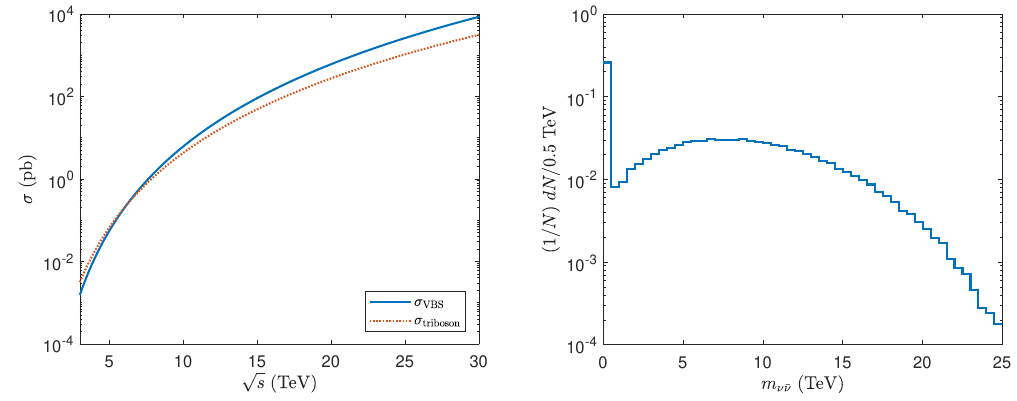
Figure 2 . Left: a comparison of σ VBS and σ triboson in eq. (2.6) for µ + µ − → γγν ¯ ν , as a function √ of s with f T / Λ 4 = 0 . 5 TeV − 4 allowed by LHC constraints. Right: the normalized distribution 5